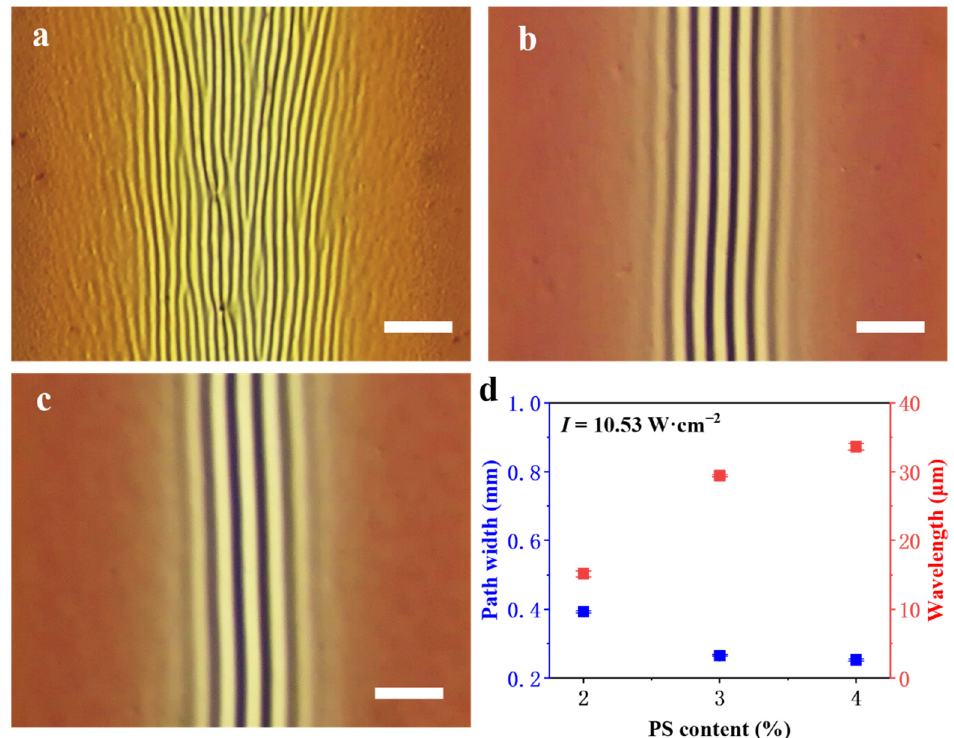
Figure 6. Optical images of wrinkles of ( a ) (2% PDO 3 -2% PS)/PDMS, ( b ) (2% PDO 3 -3% PS)/PDMS, and ( c ) (2% PDO 3 -4% PS)/PDMS induced by a moving laser beam (e.g., I = 10.53 W·cm − 2 , V = 1 mm·s − 1 ). ( d ) The dependence of the wrinkling path width and the wrinkle wavelength on the PS content. Scale bars: 100 μ m.